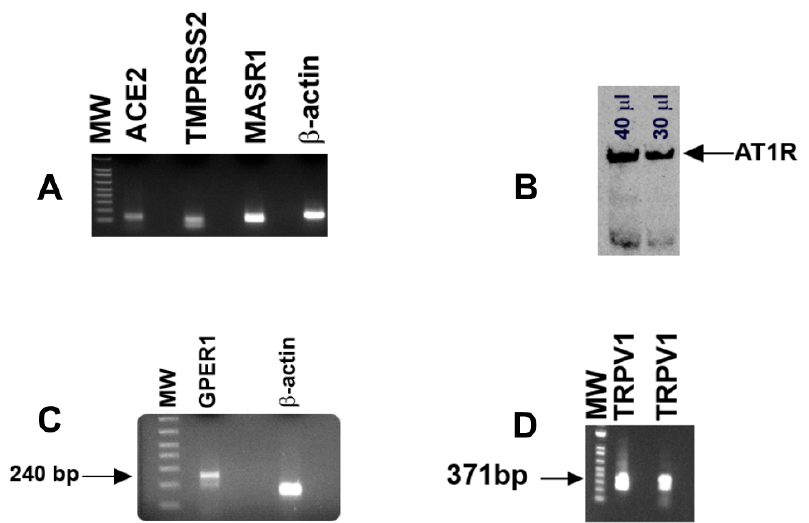
Figure 2. Detection of ACE2, TMPRSS2, MASR1, β -actin, AT1R, GPER1, and TRPV1 in HBO cells: ( A ) in HBO cell lysates, RT-PCR primers (Table 1) for ACE2 (124 bp), MASR (117 bp), TMPRSS2 (105 bp), and β -actin (153 bp) yielded single bands of predicted sizes; ( B ) in Western blot experiments, AT1R antibody (1:500 dilution) detected a single band of AT1R in HBO cell lysate. Antibody binding was responsive to different concentrations of protein loading of the HBO cell lysate (30 or 40 µL); ( C , D ) using human primers for GPER1 and TRPV1 (Table 1), RT-PCR yielded a single band of 240 bp ( C ) and 371 bp ( D ), respectively. TRPV1 mRNA RT-PCR product was sequenced and was found to be specific for the TRPV1 gene NM_080705.4 (Figure S2). Molecular weight (MW) DNA ladder bands correspond to 100–800 bp (bottom to